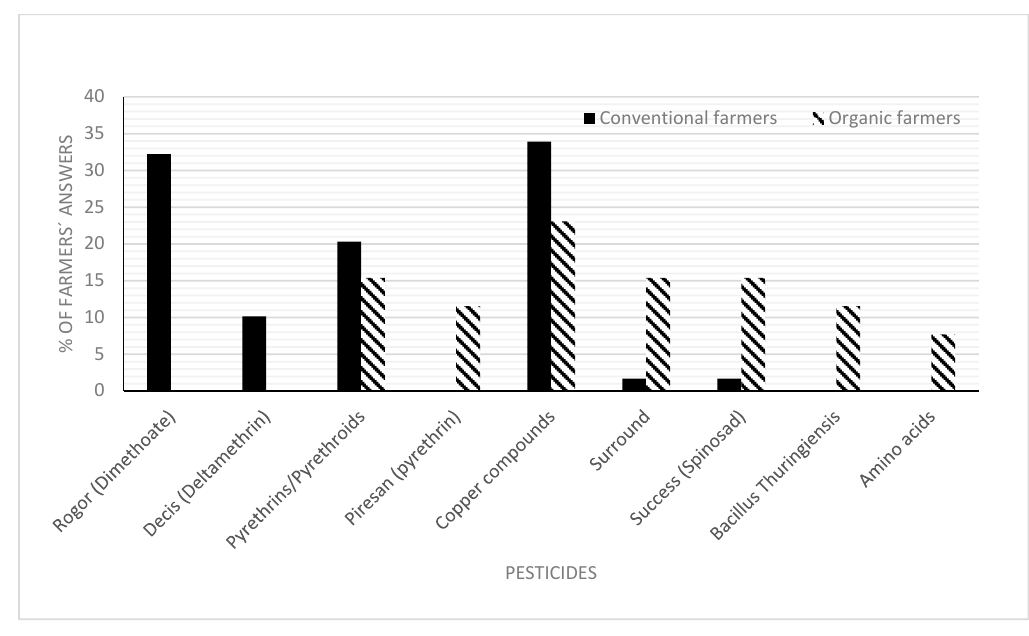
Figure 5. Pesticides (excluding herbicides used against weeds) used on olive trees by organic ( n = 16) and conventional ( n = 23) olive farmers in in Messenia, Greece.